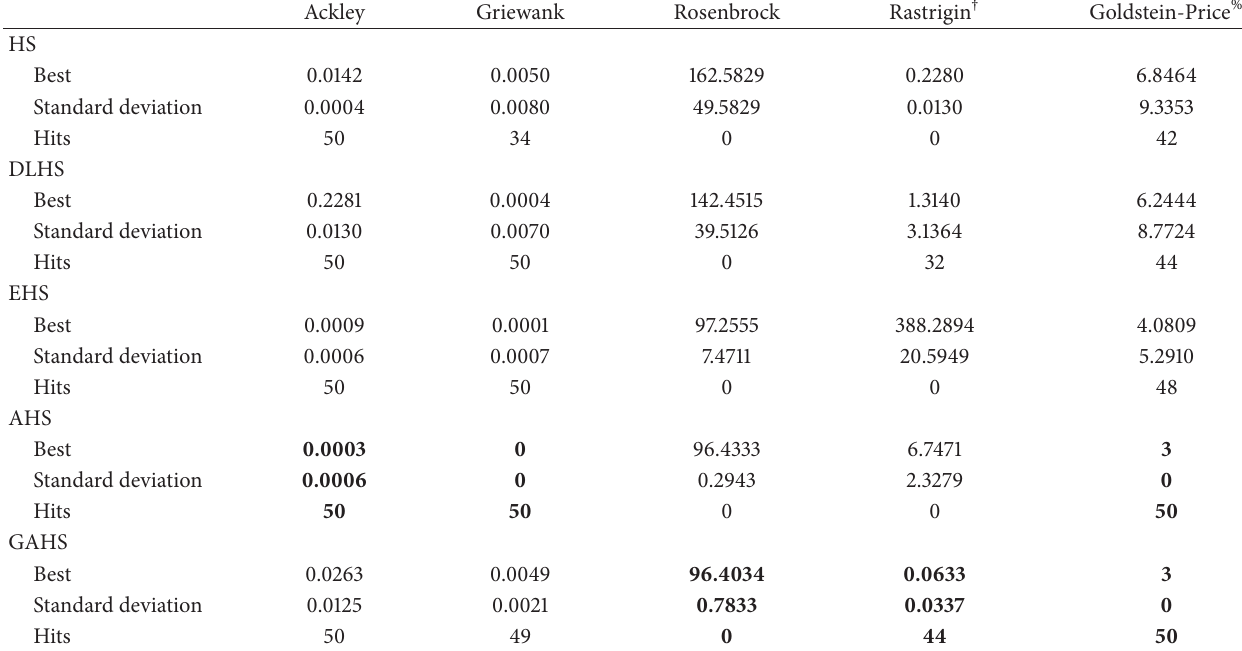
Table4:Inthistable,theperformanceofGAHSiscomparedwiththeotherHSvariants.Allscoresareaveragedover50runs,andallfunctions except Goldstein-Price are implemented in 100 dimensions. The optimisers were allowed to run for 500,000 function evaluations except for Goldstein-Price which was allowed only 10,000 evaluations. The best results are again indicated in